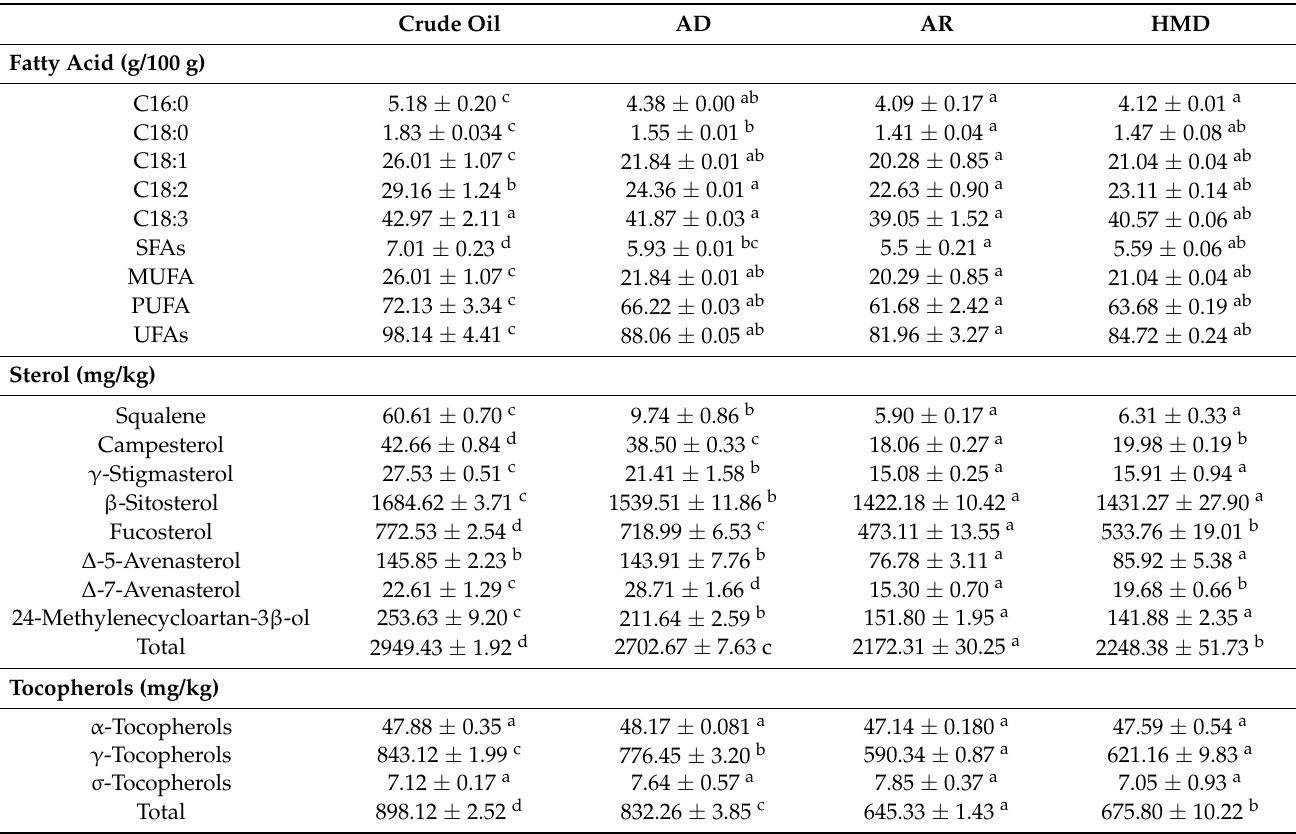
Table 1. Fatty acid composition, tocopherols, and phytosterols contents in PSOs were obtained from crude oil, adsorption deacidification, alkali refining, and oil-hexane miscella